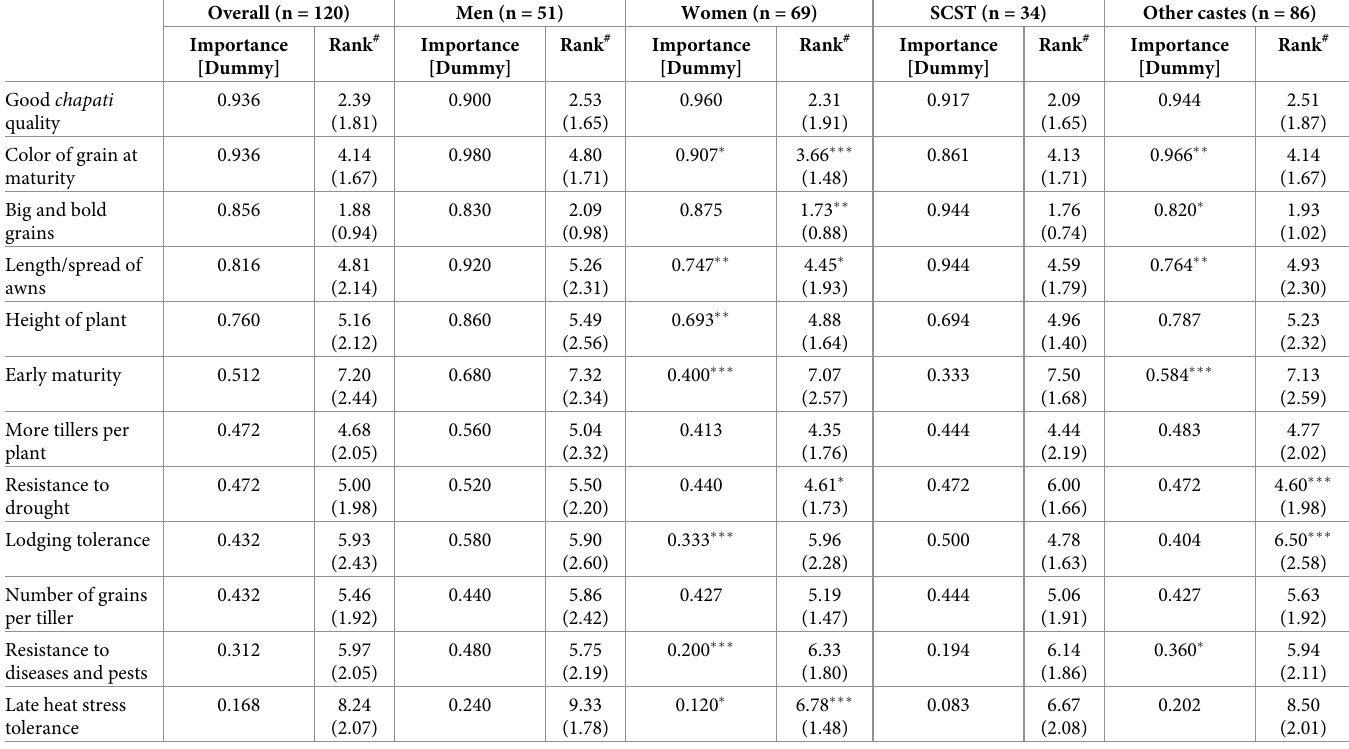
Table 4. Initial ranking analysis on wheat varietal